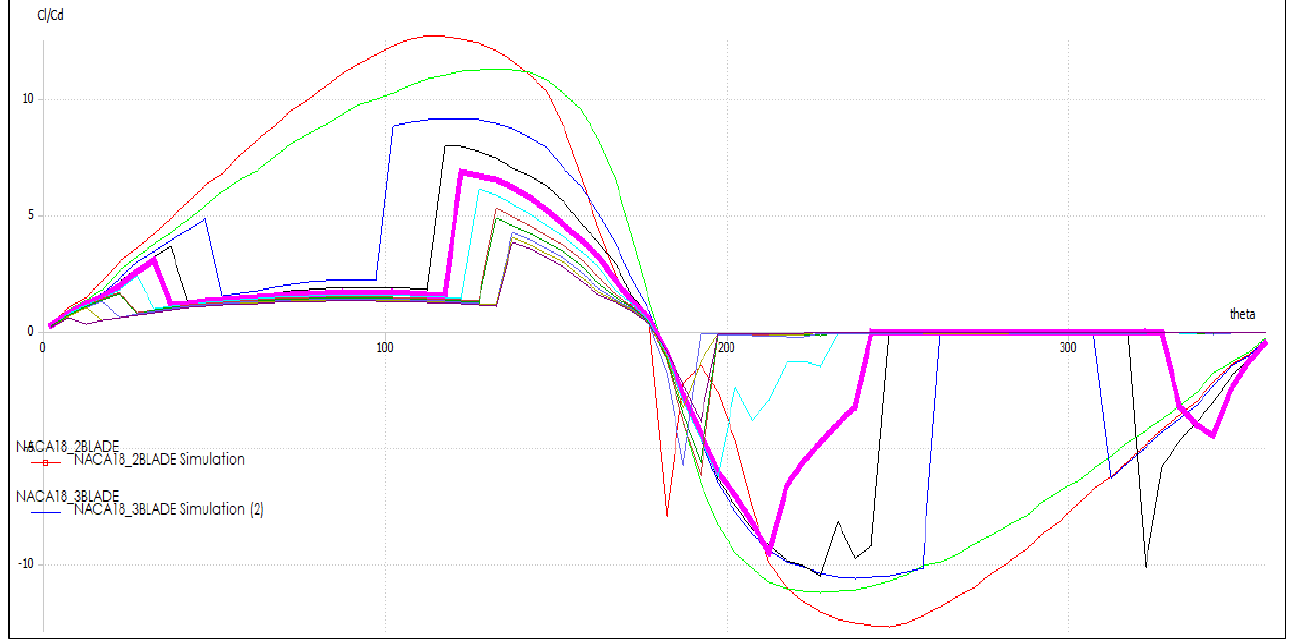
Figure 31. Cl/Cd vs theta plot of bottom-section for TSR 3